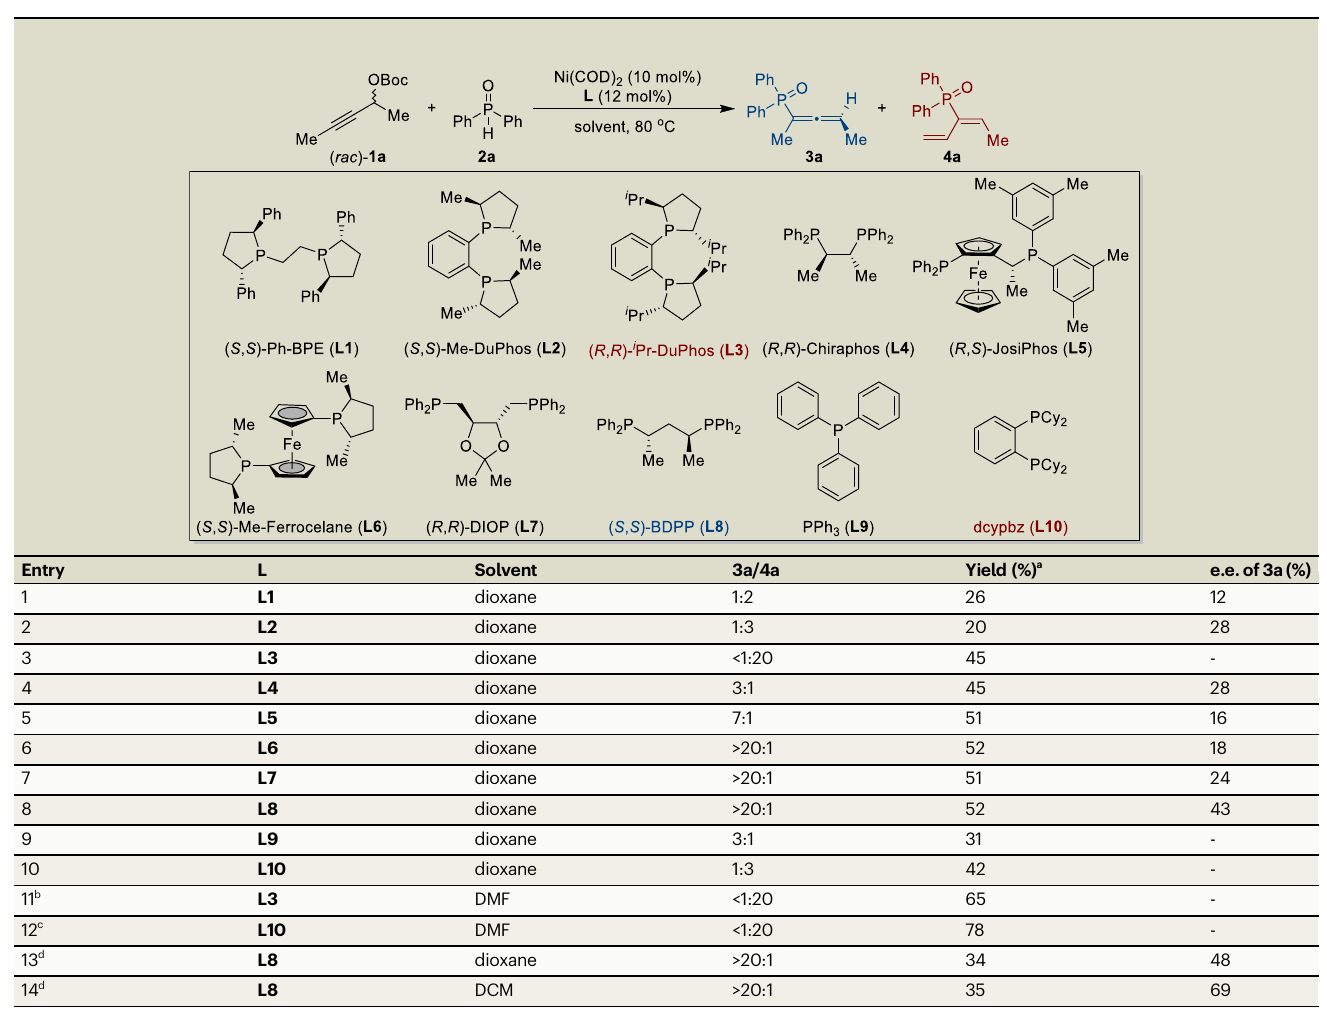
Table 1 | Condition